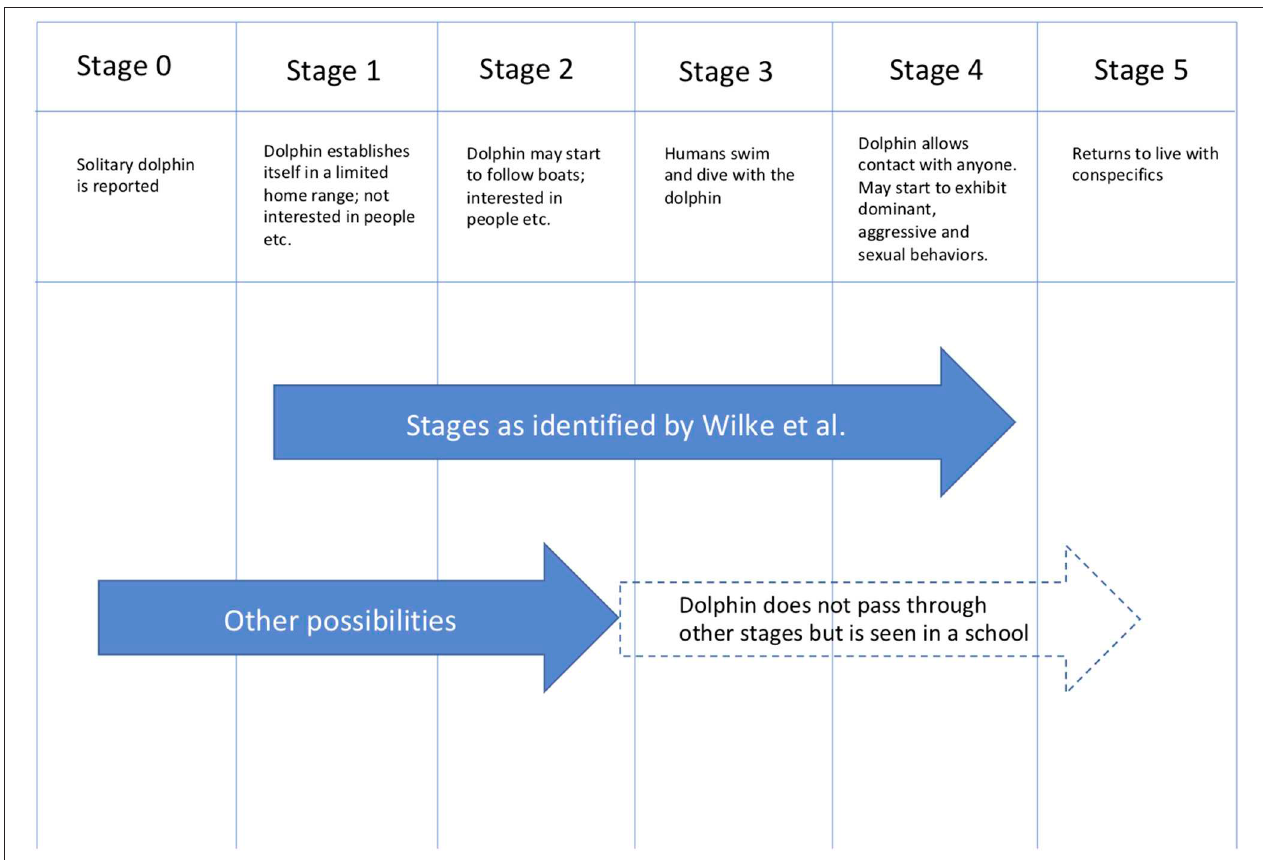
FIGURE 1 | Solitary dolphin “sociability” stages [including some details adapted from Wilke et al.